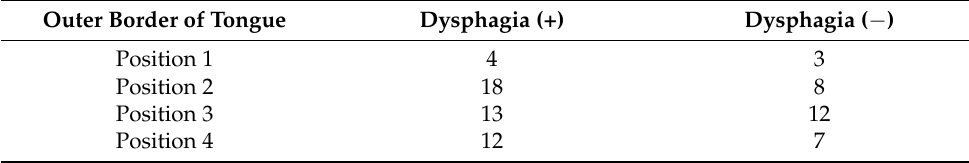
Table 4. Prevalence of the horizontal position of hyoid